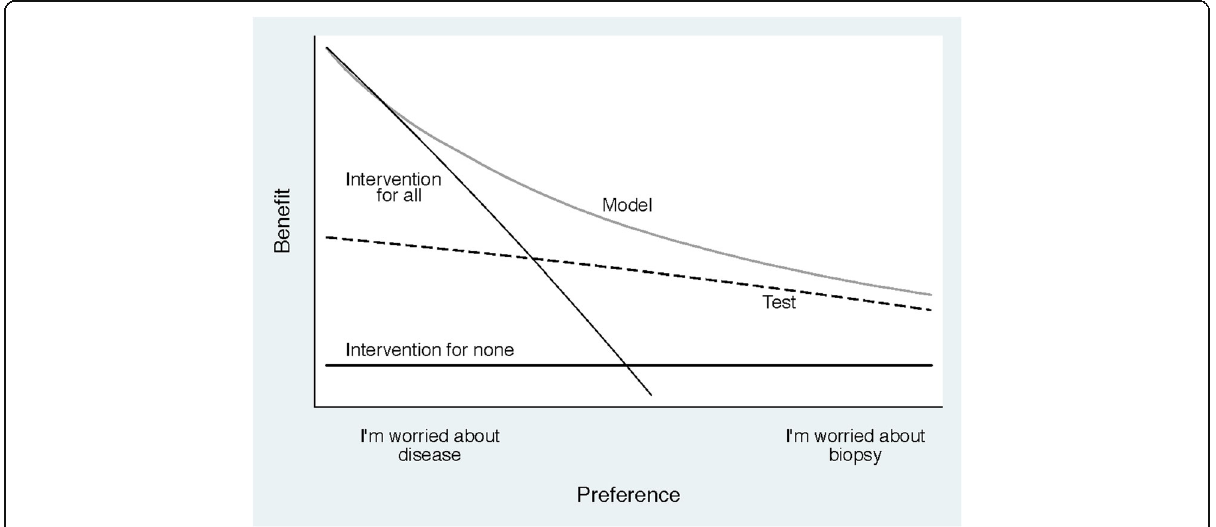
Fig. 1 A decision curve plotting benefit against